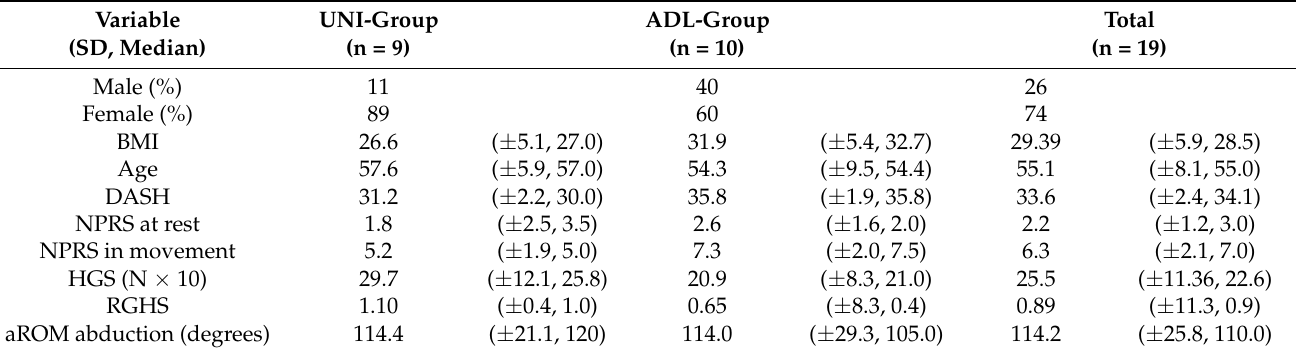
Table 1. Characteristics of participants at the beginning of rehabilitation, mean values of BMI, age, DASH, pain (NPRS), hand grip, and aROM of the affected